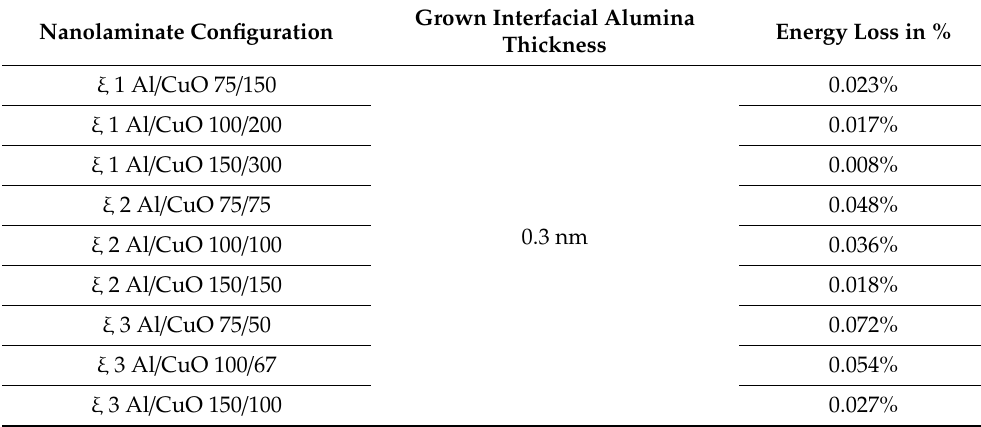
Table 2. Interfacial alumina thickness and Energy Loss (EL%) after 30 years of storage at the ambient temperature for 9 sets of Al / CuO nanolaminates (3 stoichiometries and, for each, 3 bilayer